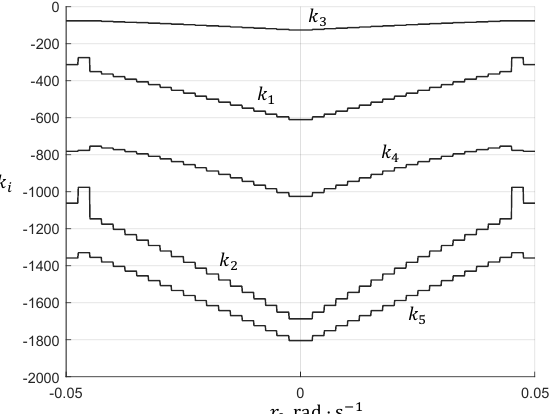
Figure 8. Feedback coefficients k i ( i = 1,5) synthesized for the path-following controller (7) as functions of the VT’s angular speed r 0